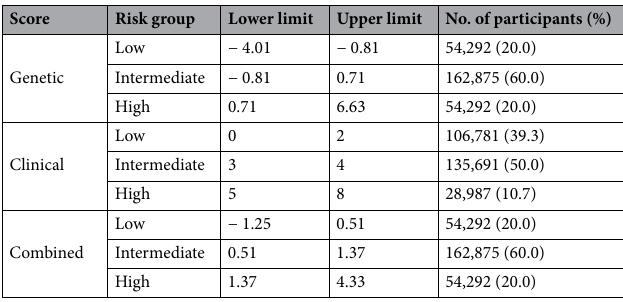
Table 1. Risk group definitions.